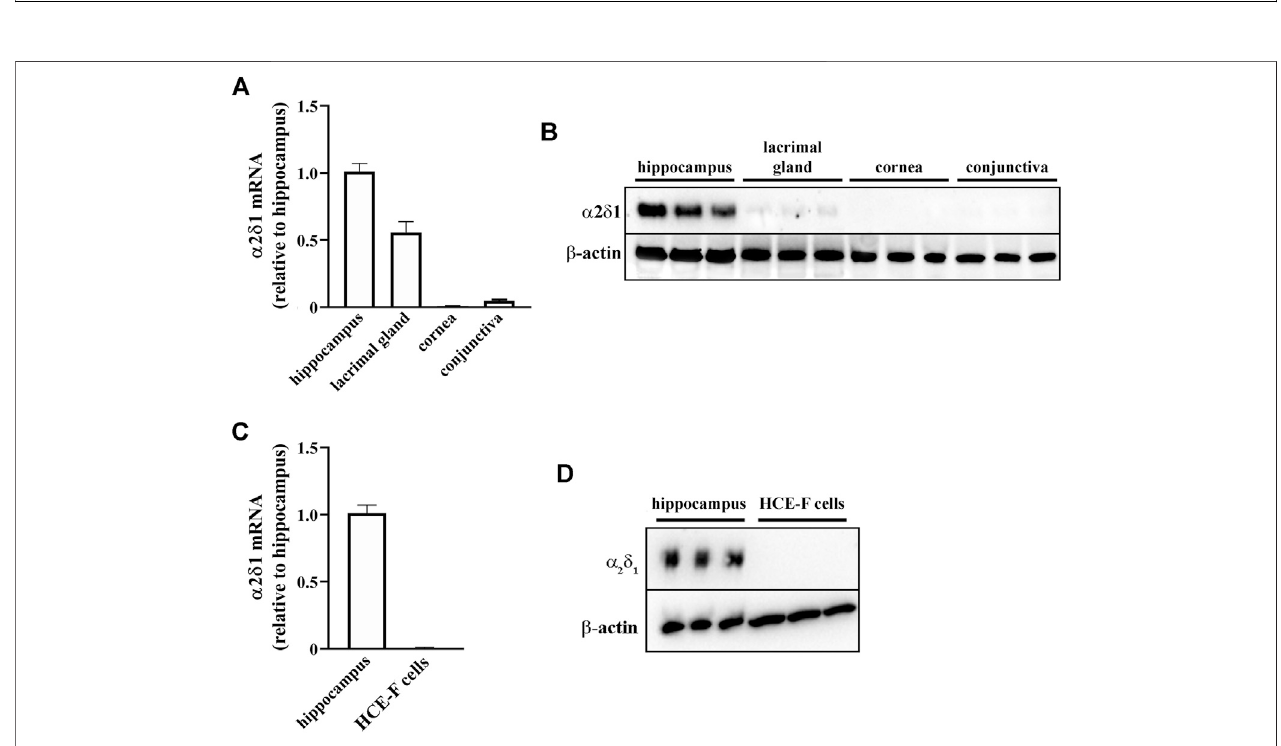
FIGURE 4 | Levels of α 2 δ 1 in rabbit hippocampus, ocular tissues and HCE-F cells. (A) Transcript levels of α 2 δ 1 in hippocampus, lacrimal gland, cornea and conjunctivaasdeterminedbyqPCR. (B) Representativeblotsdepictinglevelsof α 2 δ 1inhippocampus,lacrimalgland,corneaandconjunctivaasdeterminedbyWestern blotting. (C) Transcript levels of α 2 δ 1 as determined by qPCR. (D) Representative blots depicting levels of α 2 δ 1 in HCE-F as determined by Western blotting. Data are plotted as mean ± SEM ( n (cid:2) 6 hippocampus or tissue samples or n (cid:2) 5 HCE-F